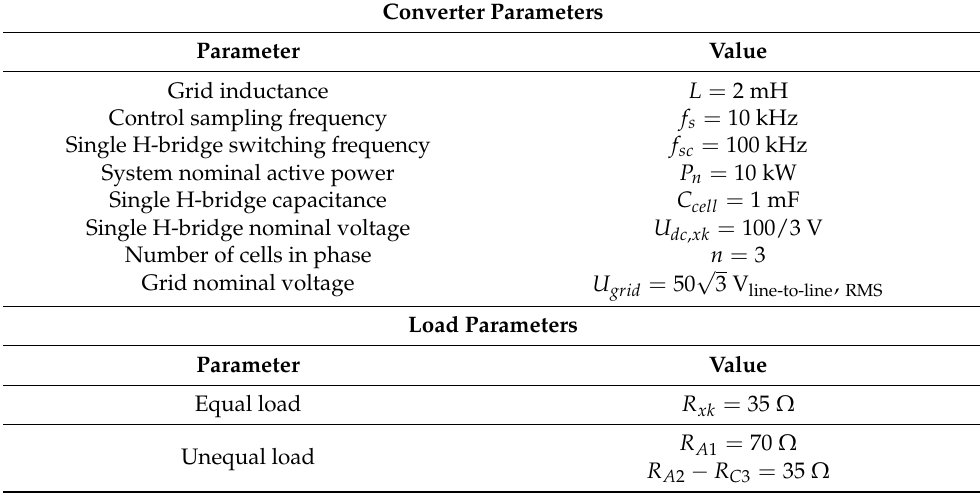
Figure 13. Simplified experimental model. Table 2. Experimental setup parameters.